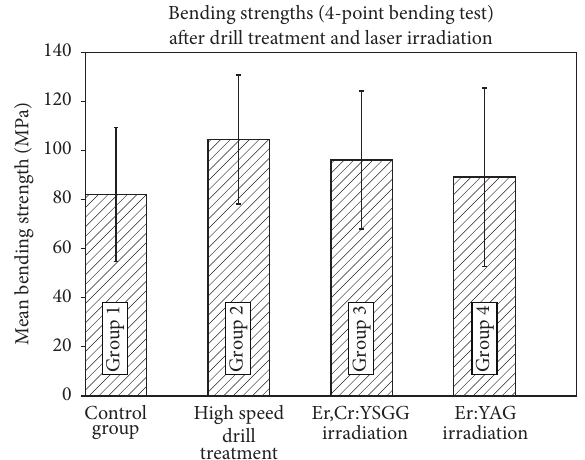
Figure 1: Illustration of the 4-point bending test results showing bending strengths for the control and the 3 test